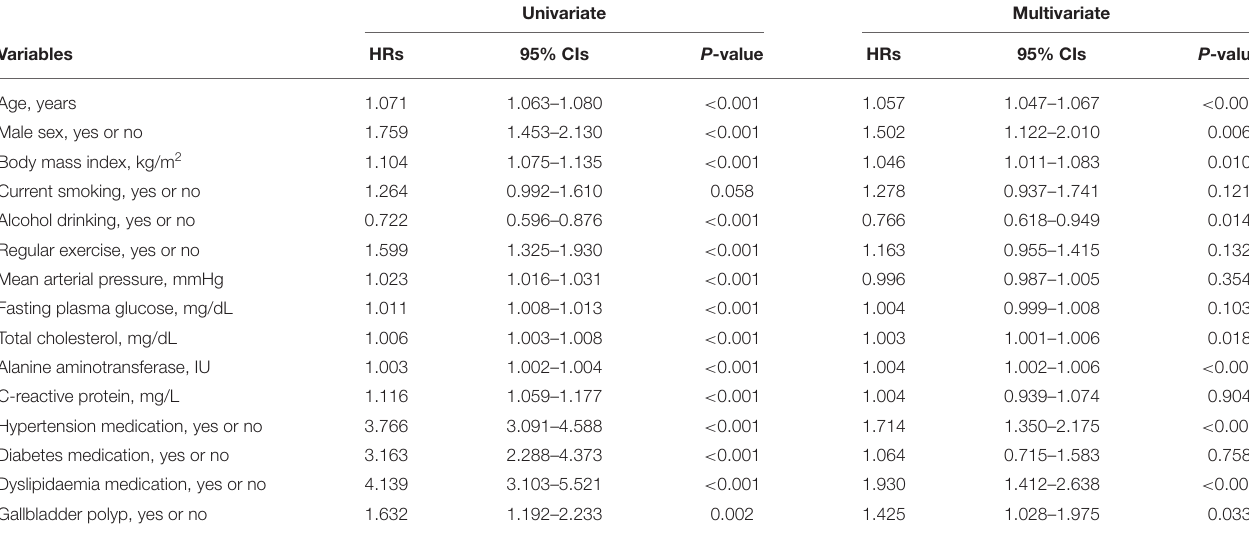
TABLE 3 | Univariate and multivariate Cox proportional-hazards regression models for incident ischaemic heart disease.